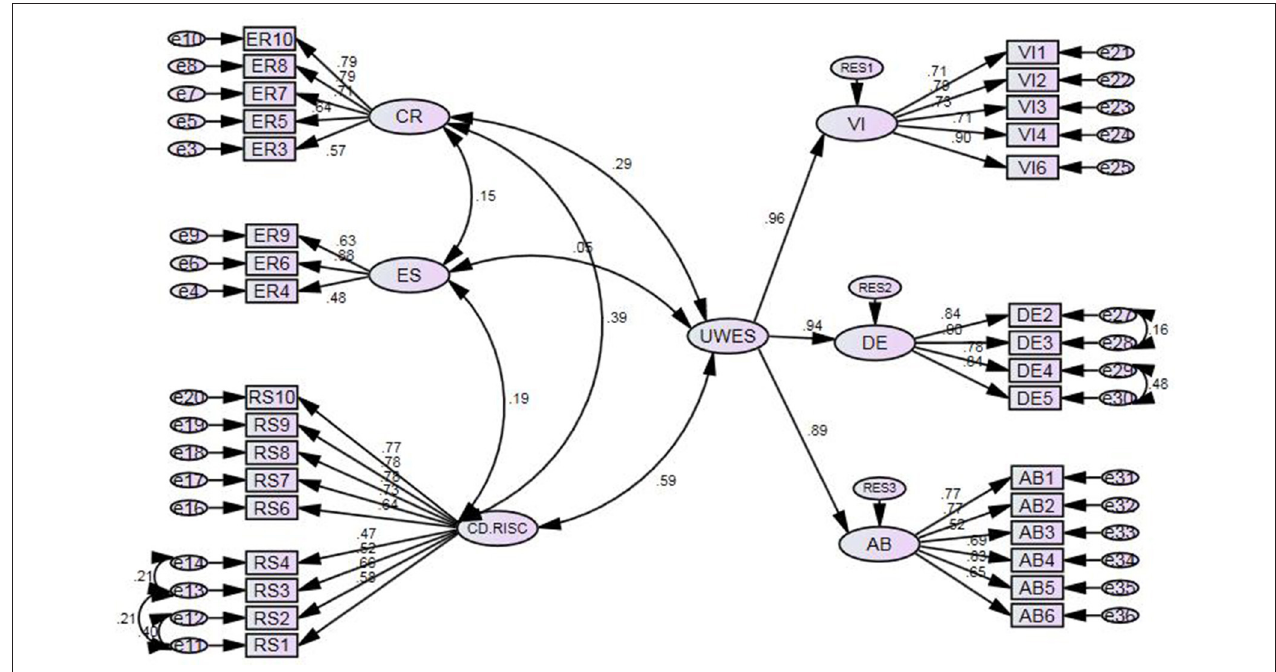
FIGURE 1 | The final modified CFA model with standardized estimates.